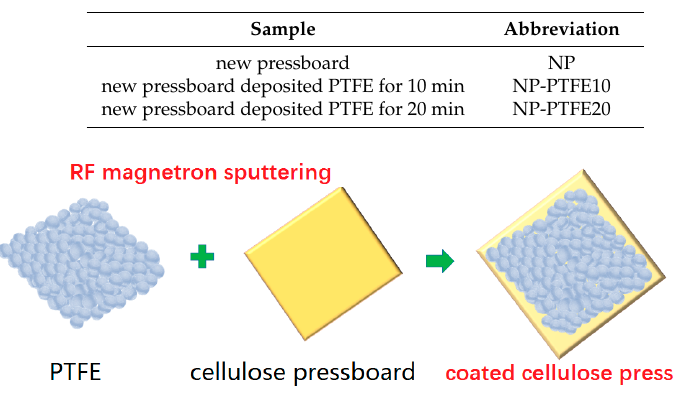
Figure 1. RF magnetron sputtering polytetrafluoroethylene (PTFE) functional film on the cellulose pressboard surface.